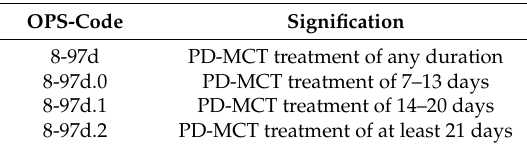
Table 2. Procedural codes for